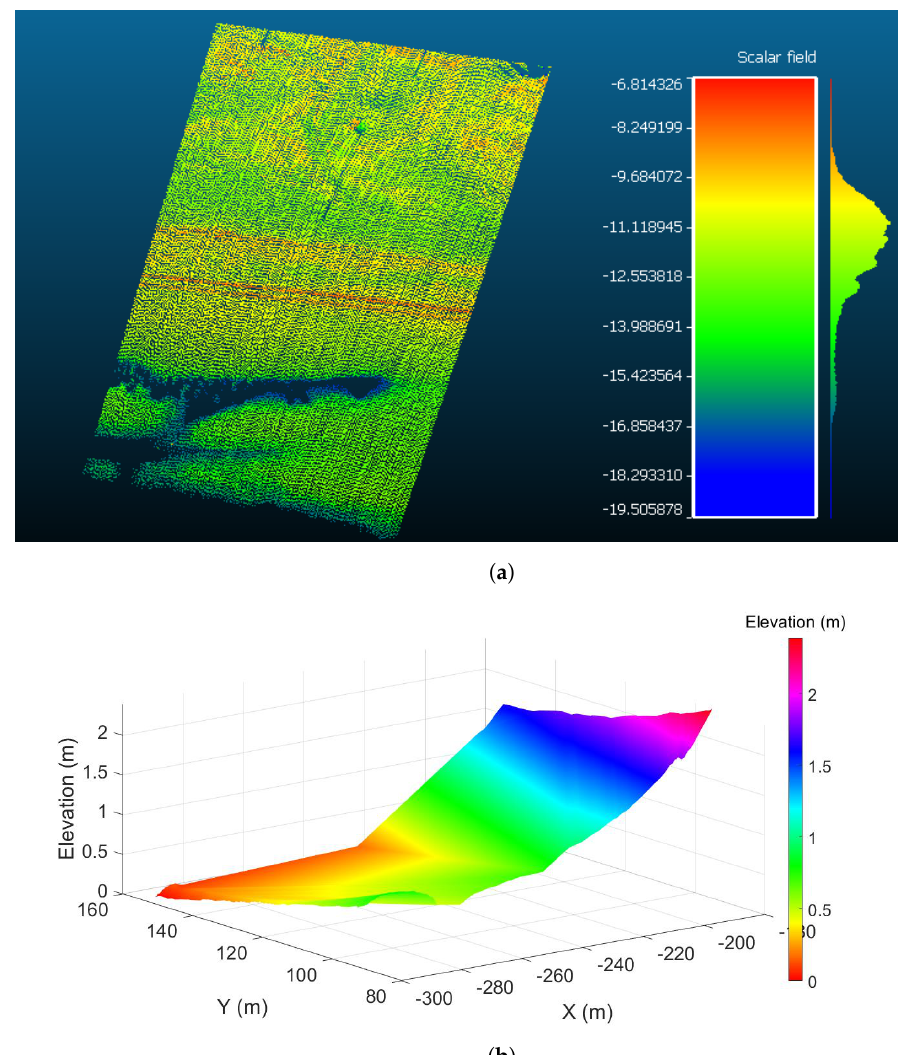
Figure 5. ( a ) Point-cloud overview of a section of the scanned area with backscatter intensity (dB). The top of the image corresponds to the end of the dune area; the bottom corresponds to the swash zone. The areas without data points are due to the presence of backwater on the sand surface following high tide. The shadow of a building can be seen in the top-right corner. ( b ) Elevation profile (m) of the same section. X and Y are shown in TLS coordinates and represent the distance (m) from the TLS; X = − 180 m corresponds to the end of the dune area; X = − 300 m corresponds to the swash